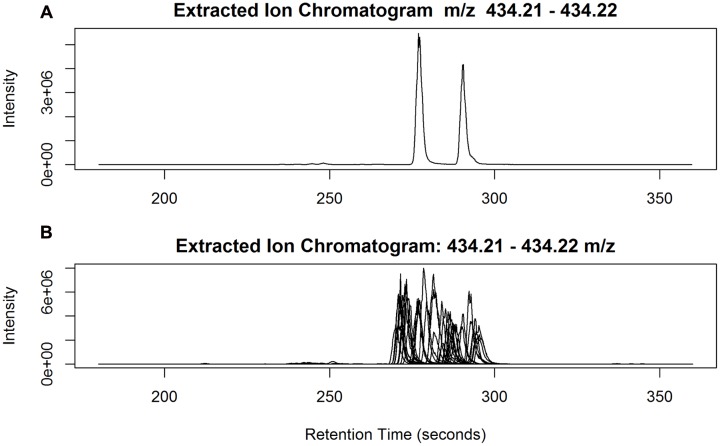
(A) Two isomeric peaks of The-Rha eluted at 4.63 min (278 s) and 4.83 min (290 s) in one sample; (B) The two peaks superimposed from all the 20 Samson samples, run in 18 different batches.